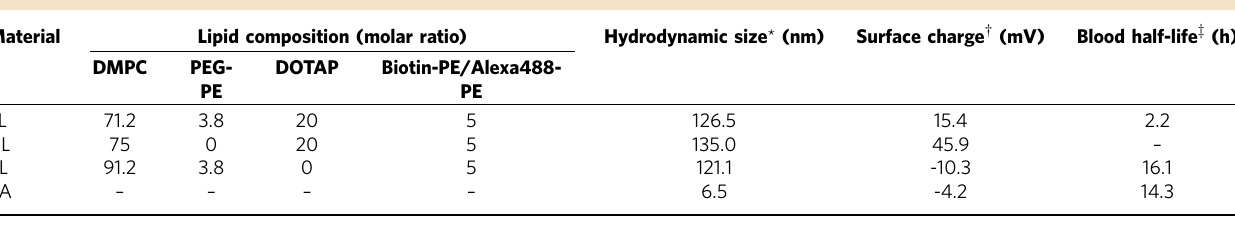
Table 1 | Biological and physicochemical properties of materials used in this study. Material Lipid composition (molar